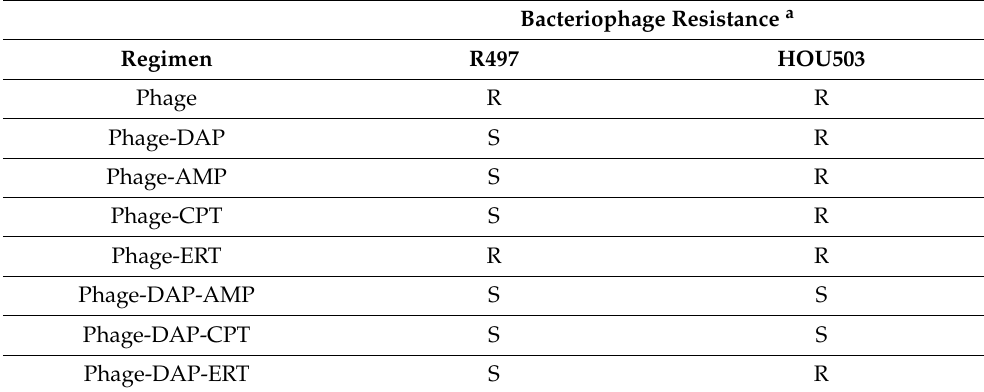
Table 2. Phage resistance check for bacteriophage and antibiotics at the end of 24 h exposure. Bacteriophage Resistance a Regimen R497 HOU503 Phage